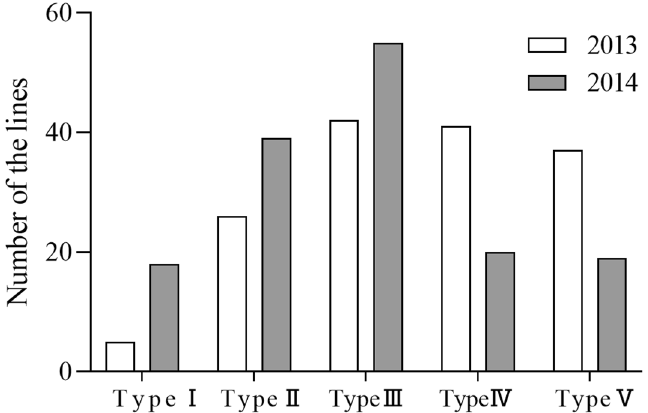
Figure 6. Distribution of total score in the RILs population. TypeI, TypeII, TypeIII, TypeIV and TypeV correspond to number of the lines with total score in the interval n > 1.00, 1.00 ≥ n > 0.50, 0.50 ≥ n > 0.00, 0.00 ≥ n > -0.50 and n ≤ -0.50.